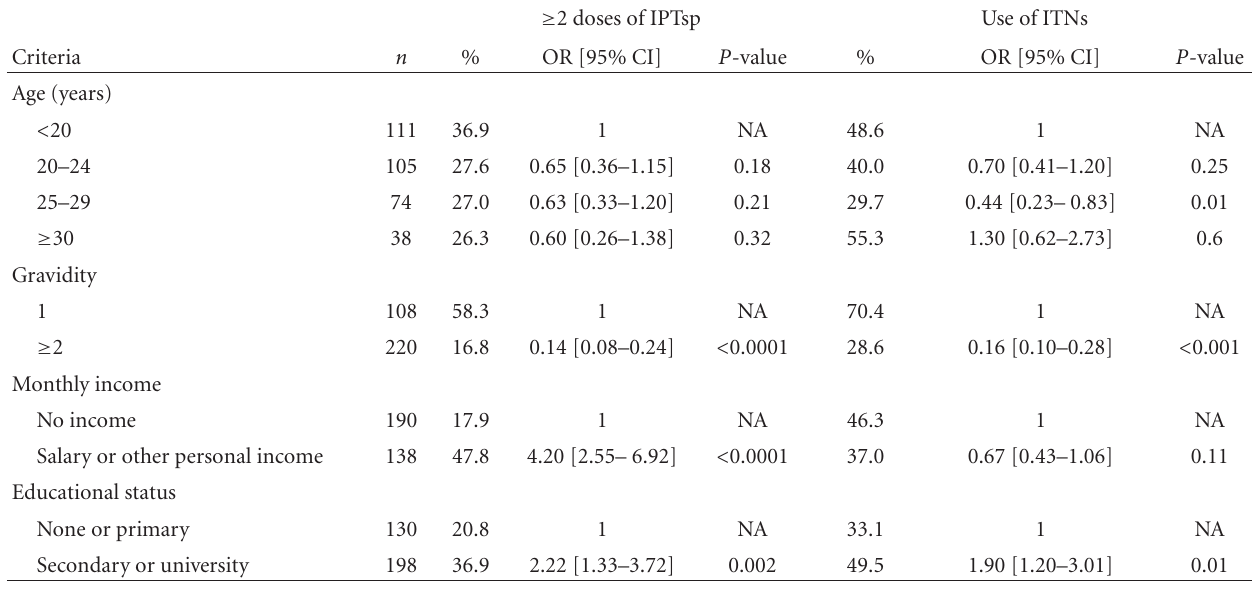
Table 1: Association between some sociodemographic characteristics and the compliance to intermittent preventive treatment with sulfado- xine-pyrimethamine (IPTsp) and insecticide-treated nets (INTs) in Bangui, September 2009, Central African Republic.